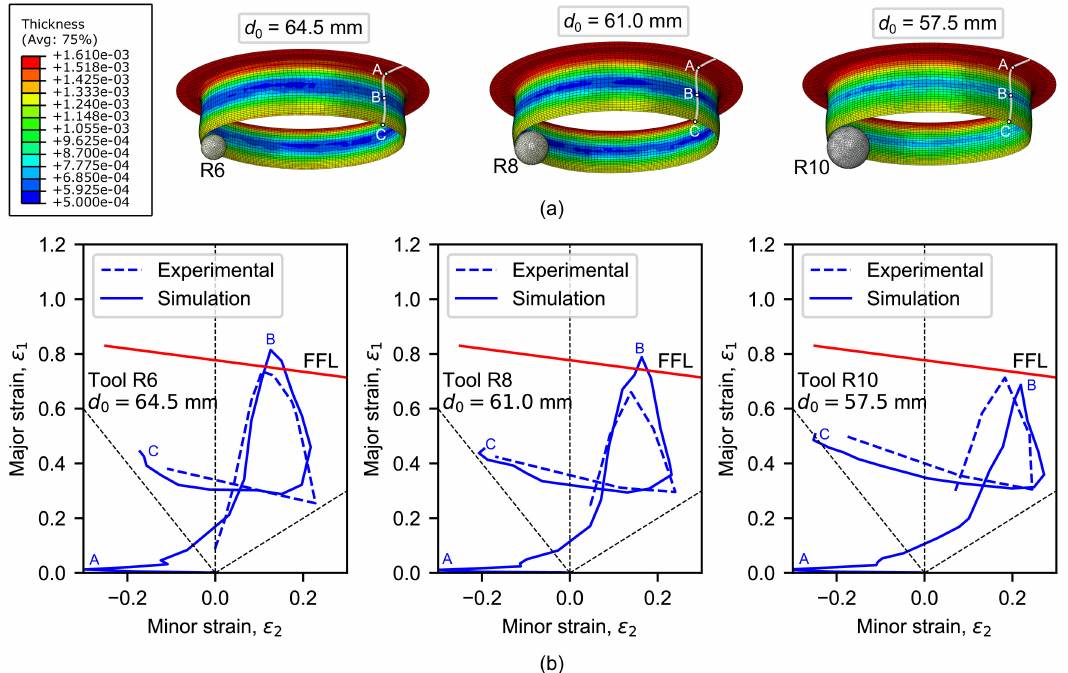
Figure 8. Simulations of hole-flanging processes by single-stage SPIF and comparison with experiments performed in [11]: ( a ) thickness distribution on 3D views and ( b ) FLD showing strain distributions along the flange.